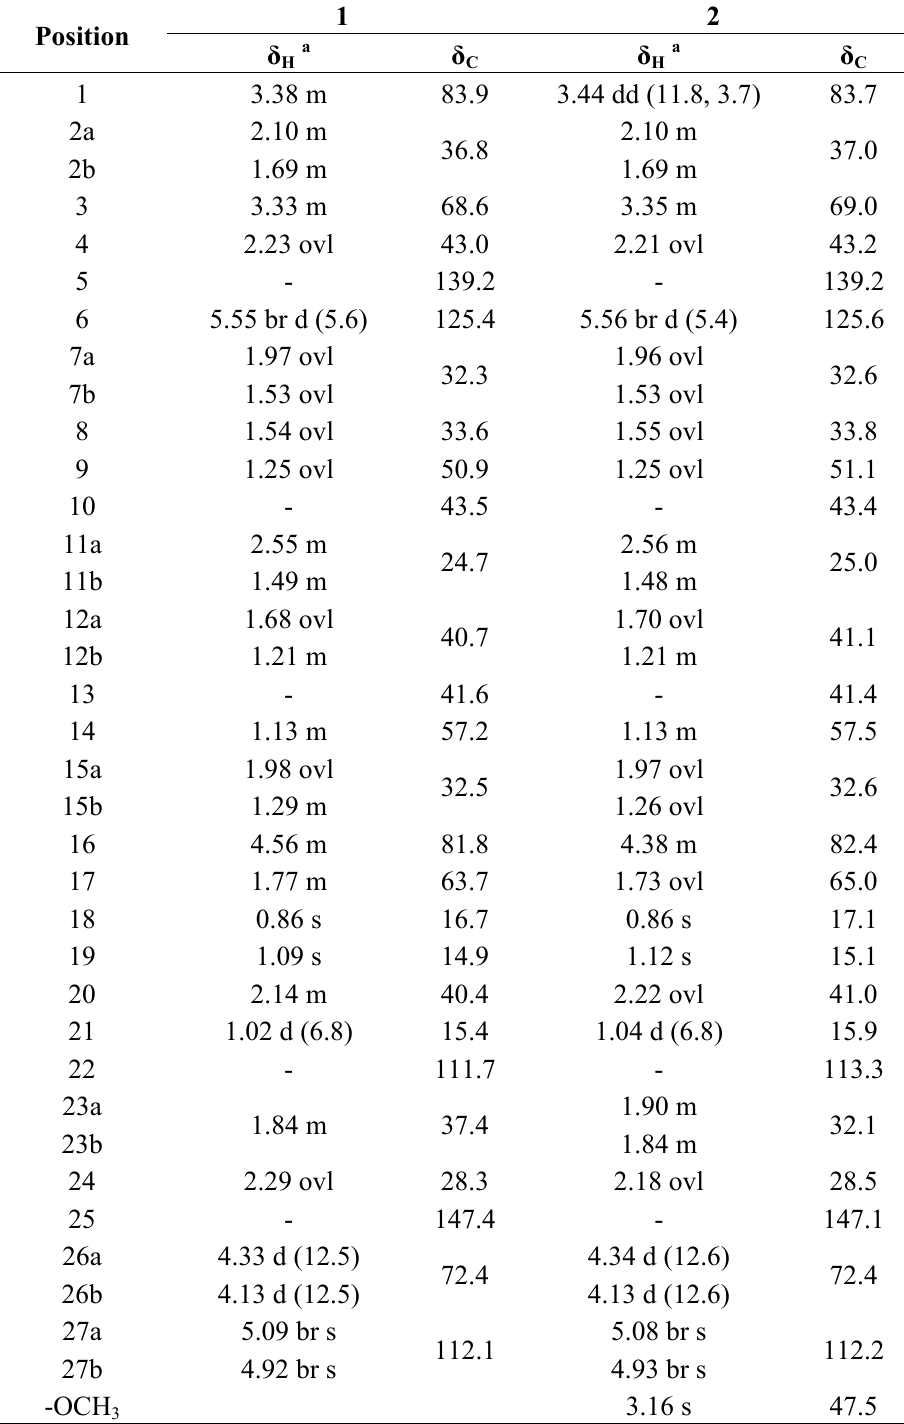
Ovl: overlapped signals; a Coupling constants are in parentheses and given in Hertz. 1 H- and 13 C-NMR assignments aided by COSY, HSQC and HMBC